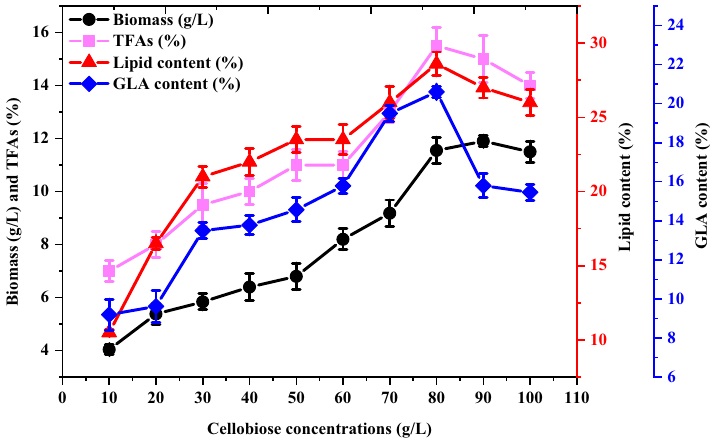
Figure 4. Influence of various cellobiose concentrations as the carbon source on biomass (g/L), lipid (%), TFA and GLA (%) yields from M. plumbeus and B. subtilis cocultures .